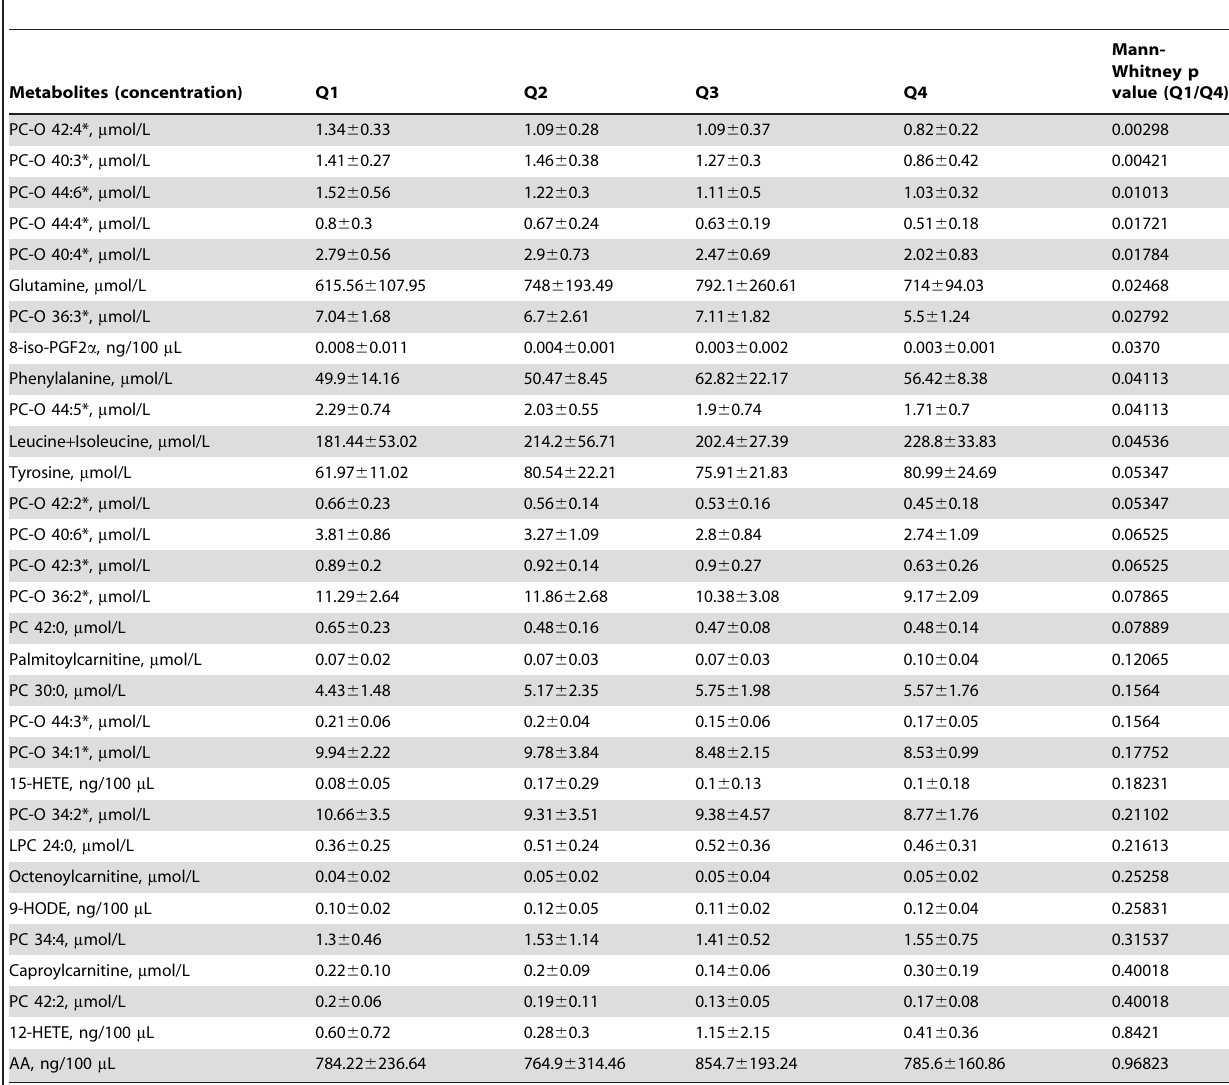
Table 3. Metabolite variations across subjects stratified according to intraperitoneal/abdominal fat ratio.